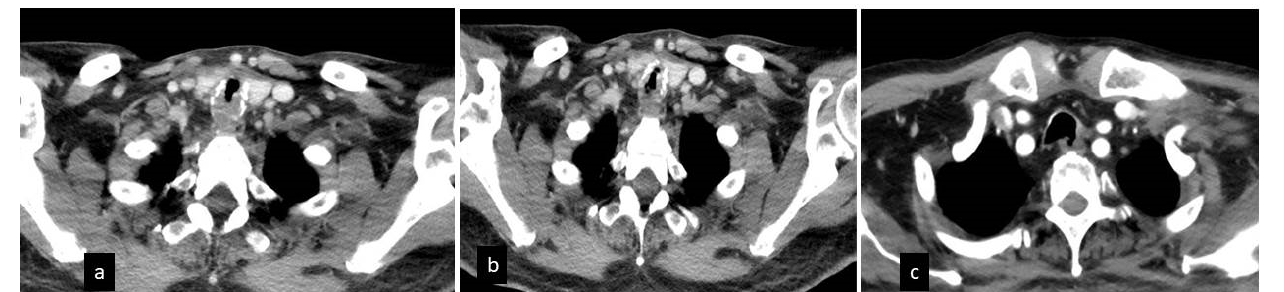
Figure 1. CT of the thorax depicting upper trachea stenosis with posterior wall thickening ( a ), an- terior wall cartilage fracture ( b ) and tracheoesophageal fistula ( c ).